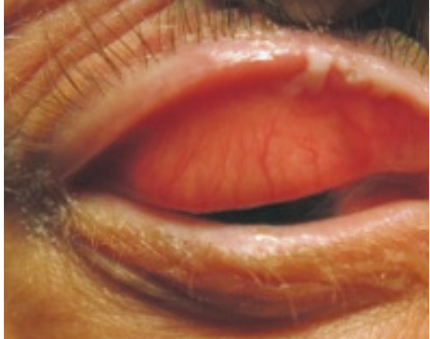
Figure 1: Photograph of the right-upper eyelid leukoplakia prior to excisional biopsy. Leukoplakia is present on eyelid margin and tarsal conjunctiva.